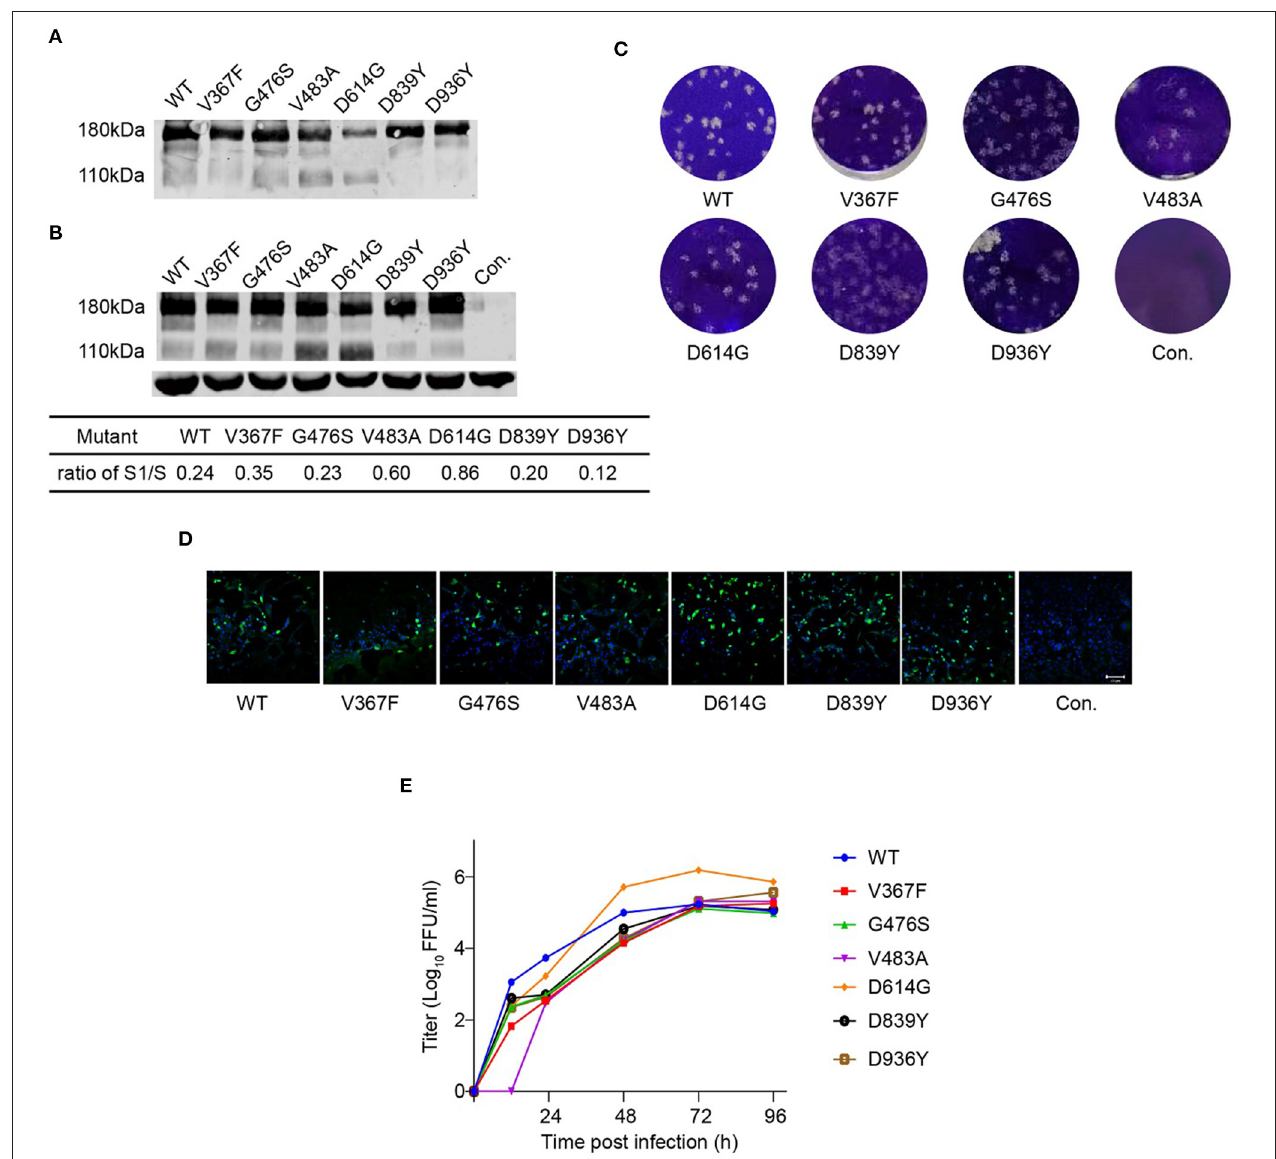
FIGURE 2 | Characterization of rVSV-S variants. Purified rVSVs (A) and lysate of rVSV producing cells (B) were analyzed by western blot using a polyclonal antibody recognizing the RBD domain of the S protein with GAPDH as input control. The result is a representative of three independent experiments. The S1/S ratio was quantified by the gray values in Image Studio Ver 5.2 Software (LICOR Biosciences, USA) and significant difference was calculated by GraphPad Prism 9.0. (C) Plaque morphology of rVSV-S variants in Vero cells at 120h post-infection. Control (Con.) is mock-infected. (D) Images of rVSV-infected Vero cells stained with serum from a convalescence patient (green). Nuclei were stained by Hoechst (blue). (E) The growth curve of rVSVs was tested in Vero cells at an MOI of 0.01. Viral titers were measured by a focus-forming assay and expressed as focus-forming units per ml (FFU/ml) ( n = 3). Error bars indicate SD. The result is representative of three independent experiments. WT: blue; V367F: red; G476S: green; V483A: violet; D614G: orange; D839Y: black; D936Y: brown.